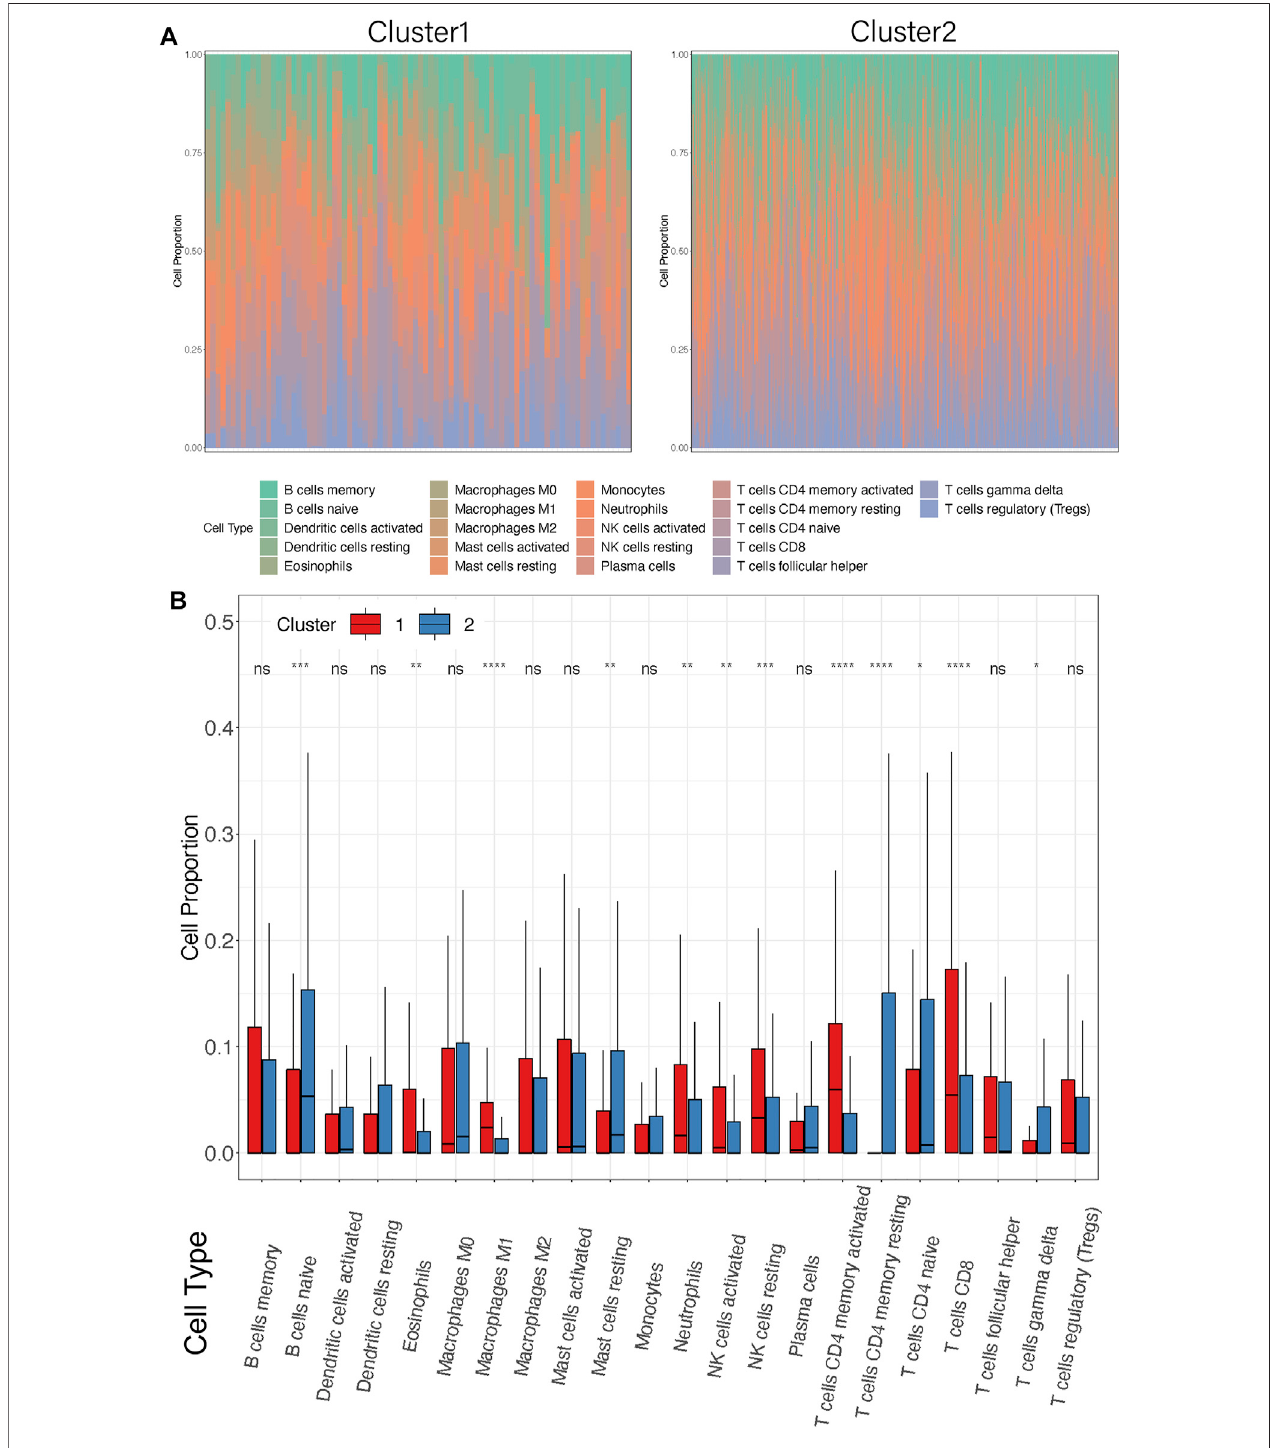
FIGURE5| Differencesinimmunecellin fi ltrationsbetweenthetwoclusters. (A) Distributionof22in fi ltratingimmunecellsubtypesbetweenthetwoclustersineach patient. Differentcolorsrepresent different immune cell types. Each bar on the X -axis representsaSTAD sample. Y -axis represents thepercentage ofdifferent celltypes in each sample. (B) Box plots showed the in fi ltration of immune cell proportion between Cluster1 and Cluster2. X -axis represents the different immune cell subtypes. Y -axis represents the cell proportion in each cluster. * p < 0.05, ** p < 0.01, *** p < 0.001, **** p < 0.0001.